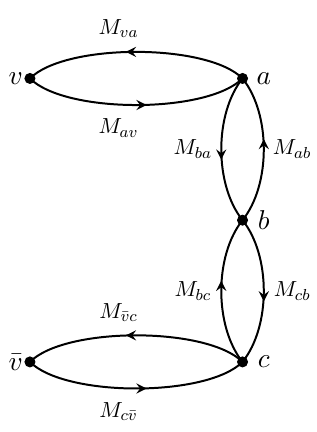
Figure 4 . Represents a quiver diagram where the arrows indicate the linear maps M av , M va , M ab , M ba , M bc , M cb , M c ¯ v , M ¯ vc and dots the spaces v , a , b , c , ¯ v on which they act.